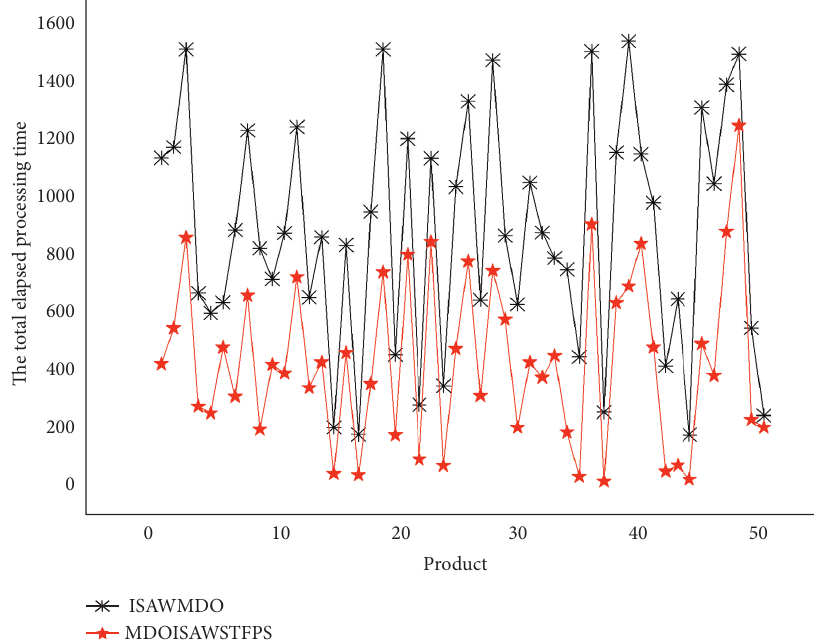
Figure 13: Comparison of the total elapsed processing time when the number of multiequipments is 10 for the two algorithms.